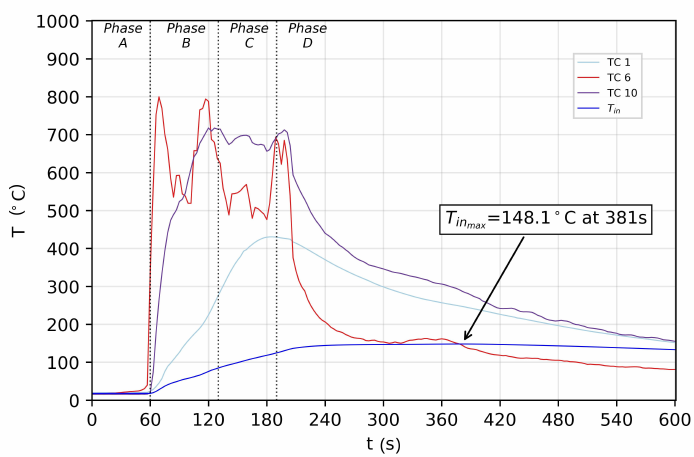
Figure 8. Temperature inside the battery in comparison to TC1, TC6, and